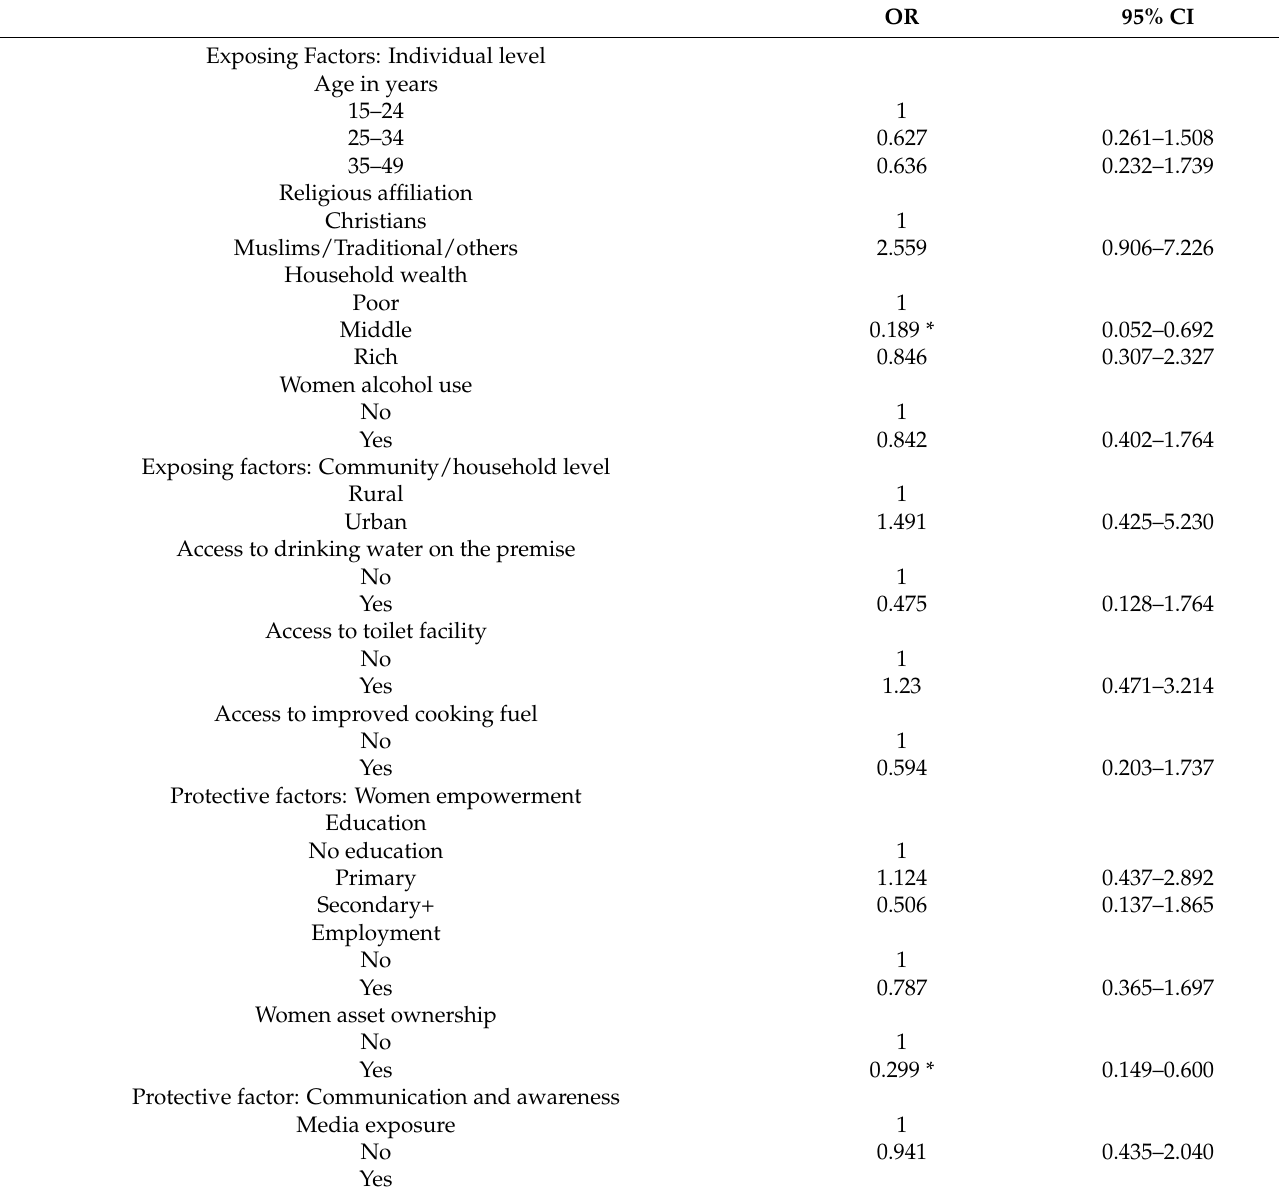
Table 3. Adjusted odd-ratios (OR) and 95% confidence (95% CI) for non-partner physical violence by hypothesized exposing and protective